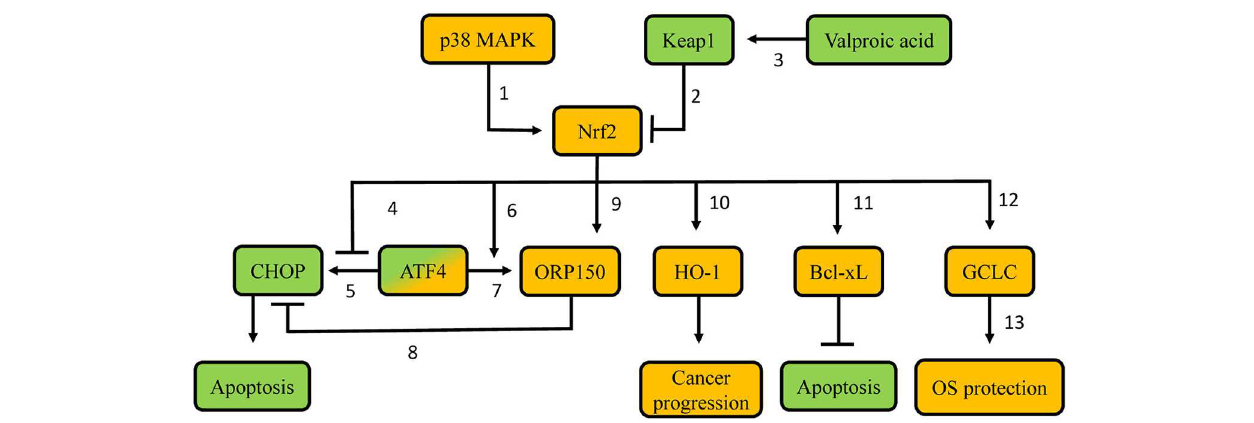
FIGURE 4 | Proposed molecular mechanisms involved in resistance of thyroid carcinoma cells to proteasome inhibitors. Green-labeled molecules promote sensitivity to proteasome inhibitors, orange-labeled molecules promote resistance to proteasome inhibitors. 1. p38 MAPK phosphorylates Nrf2, thus leading to Nrf2 nuclear accumulation; 2. Keap1 targets Nrf2 for poly-ubiquitination and proteasomal degradation; 3. Valproic acid demethylates the KEAP1 promoter, thus favoring KEAP1 gene transcription; 4. Nrf2 precludes recruitment of ATF4 to the CHOP promoter, thus decreasing CHOP transcription; 5. ATF4 promotes CHOP transcription via binding to its promoter; 6. Nrf2 promotes ATF4 recruitment on the ORP150 promoter, thus increasing ORP150 transcription; 7. ATF4 promotes ORP150 transcription via binding to its promoter; 8. Potential competition between ORP150 and CHOP; 9. Nrf2 promotes ORP150 transcription; 10. Nrf2 promotes HO-1 transcription; 11. Potentially decreased Keap1-mediated Bcl-XL poly-ubiquitination; 12. Nrf2 promotes GCLC transcription; 13. Gclc protein favors GSH synthesis. MAPK: Mitogen-activated protein kinase; Keap1: Kelch-like ECH-associated protein 1; Nrf2: nuclear factor erythroid 2-related transcription factor 2; CHOP: CCAAT/enhancer-binding protein homologous protein; ATF4: Activating Transcription Factor 4; ORP150: oxygen-regulated protein 150; HO-1: heme-oxygenase 1; Bcl-xL: B-cell lymphoma-extra large; GCLC: glutamate-cystein ligase, catalytic subunit; OS: oxidative